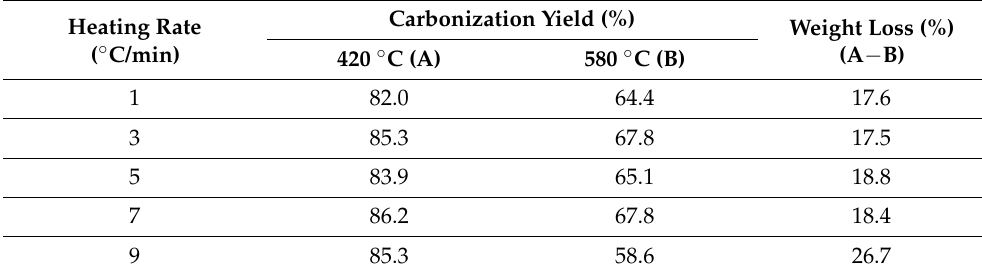
Table 1. Carbonization yield and weight loss at 420–580 ◦